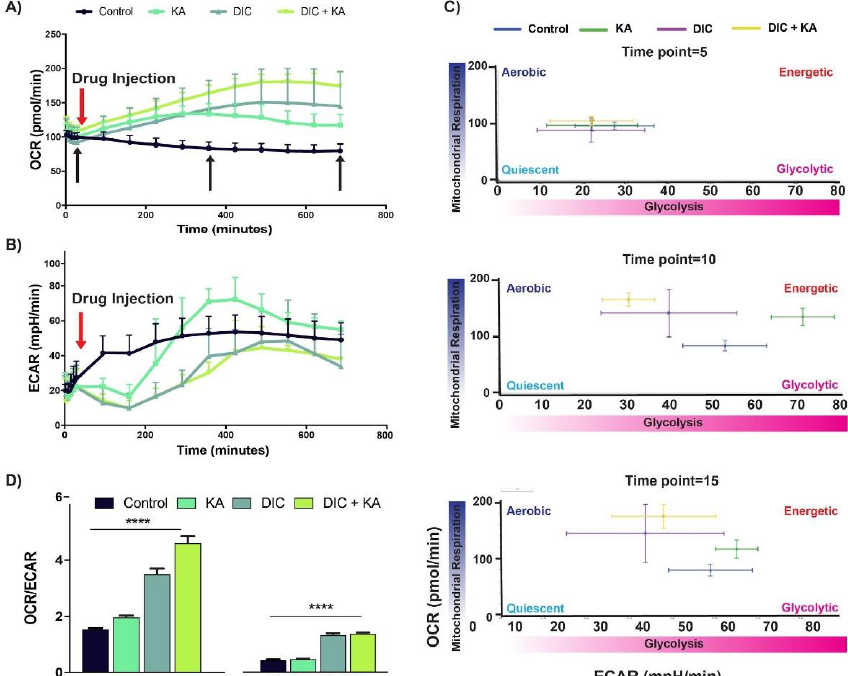
Figure 3. Diclofenac and koningic acid reduce the Warburg phenotype of cancer cells. ( A ) Oxygen Consumption Rate (OCR) and ( B ) Extracellular acidification rate (ECAR) of MCF7 cancer cells treated with, KA, diclofenac, and combination of both in real-time. ( C ) Energy map extracted from A and B under different treatments. A combination of KA and diclofenac had the highest effect on the reduction of WE phenotype in MCF7 breast cancer cells. ( D ) Glycolytic rate assay of both MCF7 and MDA-MB-231 cells confirmed the maximum reduction of WE phenotype with the combination of KA and diclofenac for 72 h. All the seahorse experiments were done in 6 replicates per condition and the data is normalized to the protein concentration of the cells per each well. The data is represented as the mean with the error bars as SD. p -values are represented as follows: **** p <